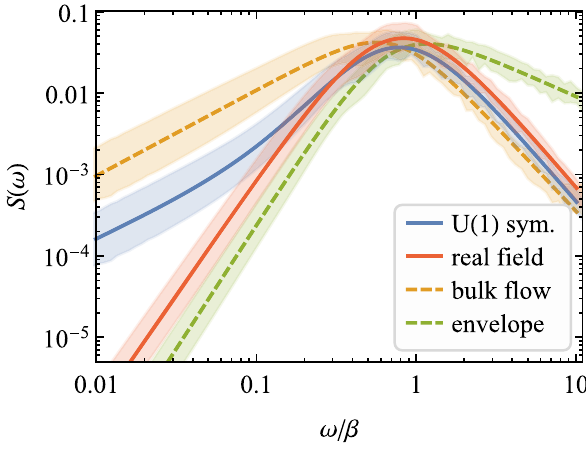
Fig. 4 GWspectrumsourcedbyscalarfieldgradients.Thesolidcurves show the spectral shape fit (19) in the U ( 1 ) symmetric case (blue) and in the case that all bubbles have equal complex phase (red) corresponding to a situation with just a real scalar field. The green and yellow dashed curves show the spectrum in the envelope and bulk flow approxima- tions. The shaded bands indicate the variance from averaging over 40